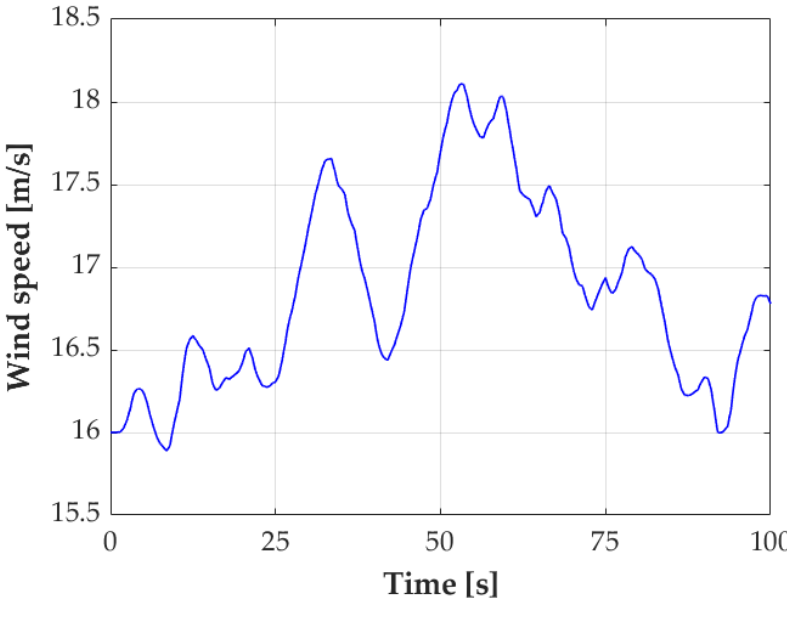
Figure 9. Wind speed. Table 2. Fuzzy logic control parameters optimized by GA.